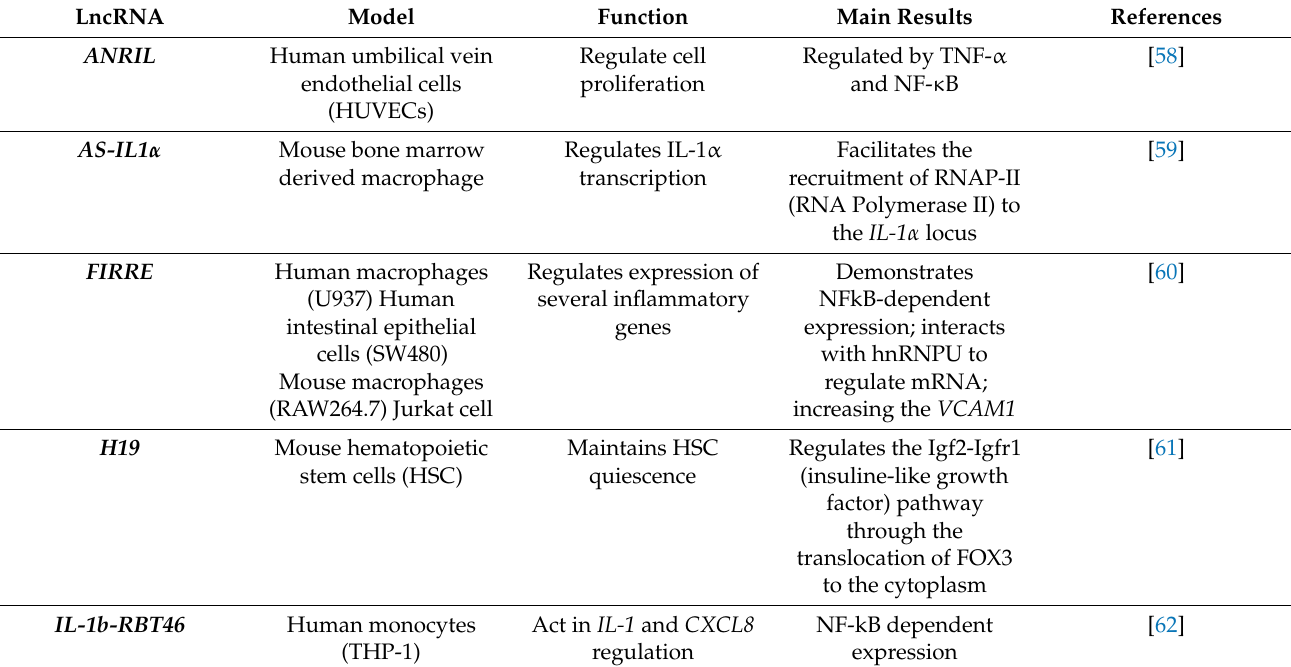
Table 1. LncRNAs roles and mechanisms in innate